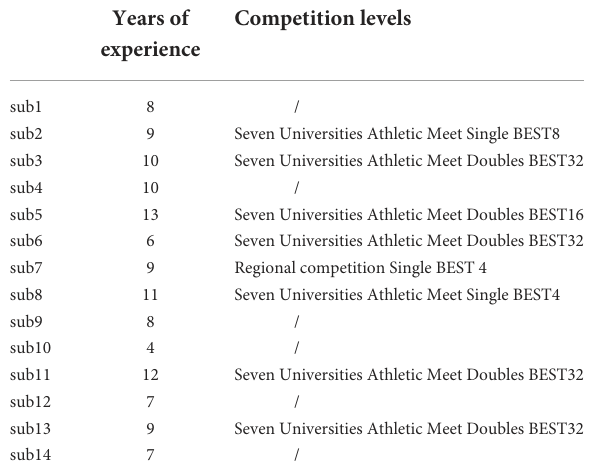
TABLE 1 Participant’s competitive history and level in table tennis.